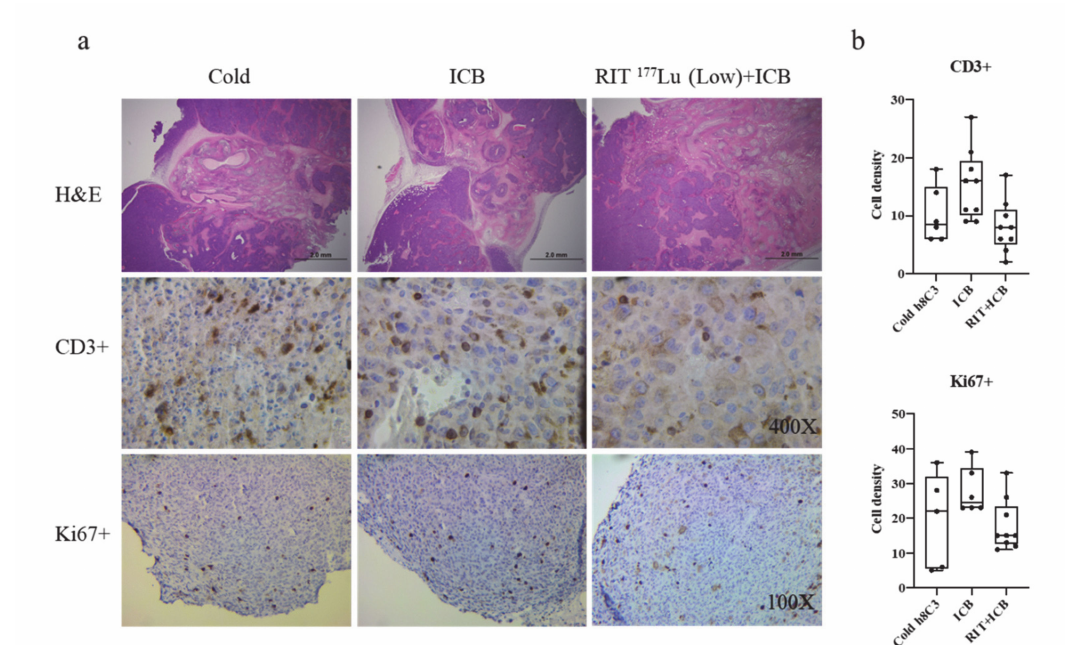
Figure 6. H&E staining and IHC staining of tumors. Panel ( a ): First row, H&E staining of tumors from cold h8C3, ICB, and RIT 177 Lu (low) + ICB treatment groups. Second row, anti-CD3 IHC staining under 400X magnification; brown staining surrounds the nuclear indicate the CD3 + cells. Bottom row, anti-Ki67 IHC staining under 100X magnification, and brown staining overlaps with the nuclear indicate the Ki67 + cells. Panel ( b ): upper row—number of CD3-positive cells in cold h8C3, ICB, and RIT + ICB treatment group; lower row—number of Ki67-positive cells in cold h8C3, ICB, and RIT + ICB treatment